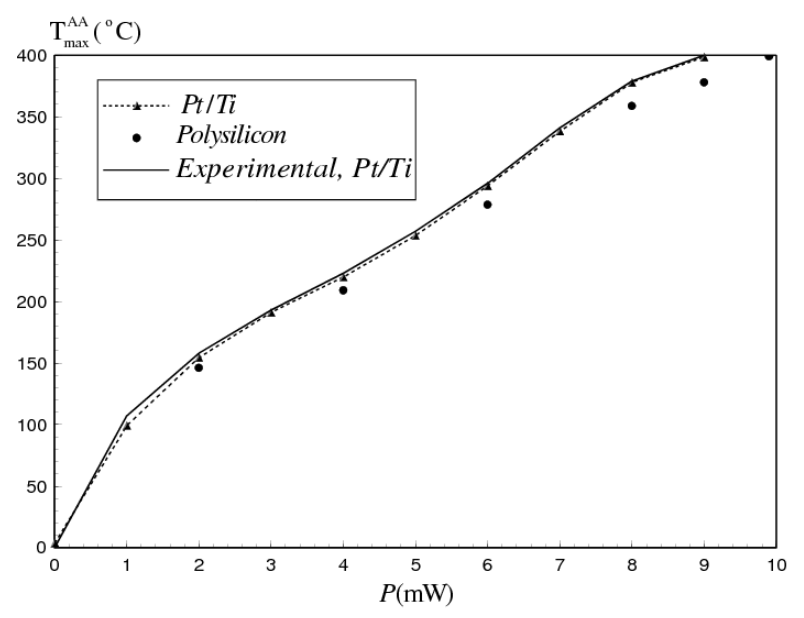
Figure 3. Power temperature relationship for different heater material calculated with substructured coupled multiphysics analysis. Experimental measurements from Mo et al.